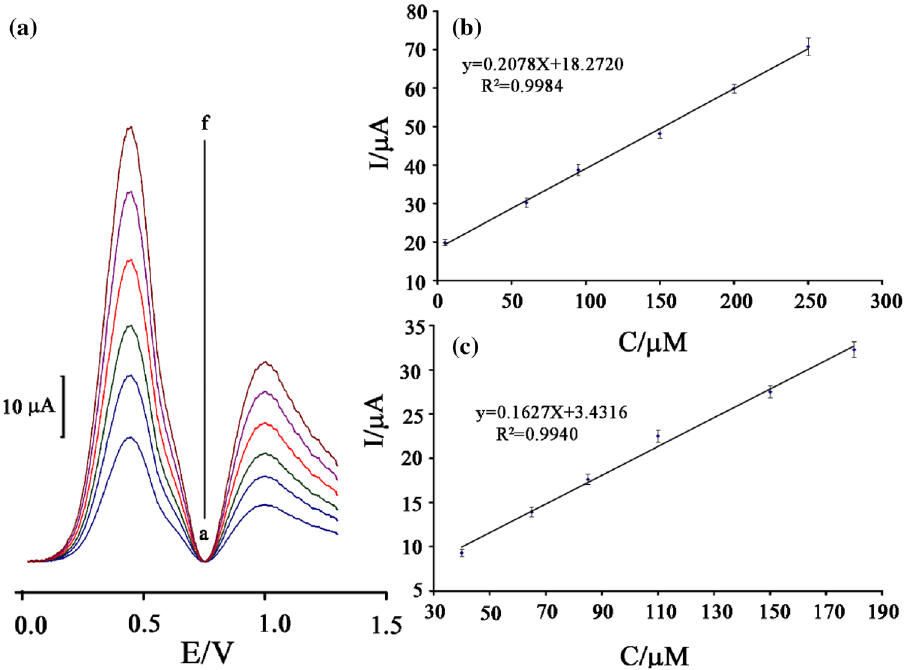
Figure 6. ( a ) differential pulse voltammograms of BPOFc/BMPF6/NiO-SWCNTs/CPE in pH 7.0 containing different concentrations of N-acetylcysteine and theophylline (from inner to outer) mixed solutions of: (a): 5.0 + 40.0 (b): 60.0 + 65.0 + 100; (c): 95.0 + 85; (d): 150.0 + 110.0; (e) 200.0 + 150; and (f) 250 + 180.0 μmol L −1 N-acetylcysteine and theophylline, respectively. ( b ) and ( c ) Plots of the electrocatalytic currents as a function of N-acetylcysteine and theophylline concentration, respectively (n = 3).